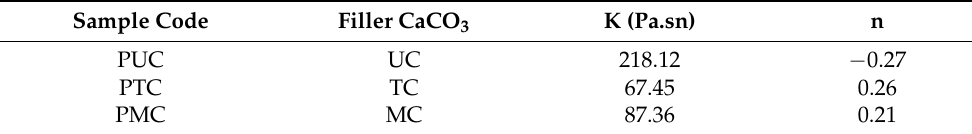
Table 3. Power law properties of prepared